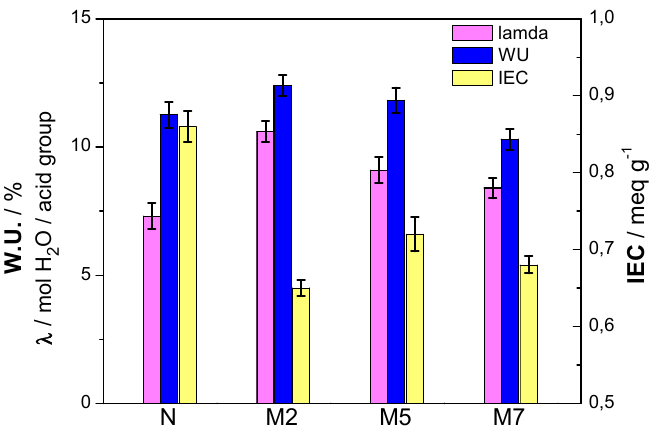
Figure 4. WU, IEC and λ of the membranes at 100 % RH.